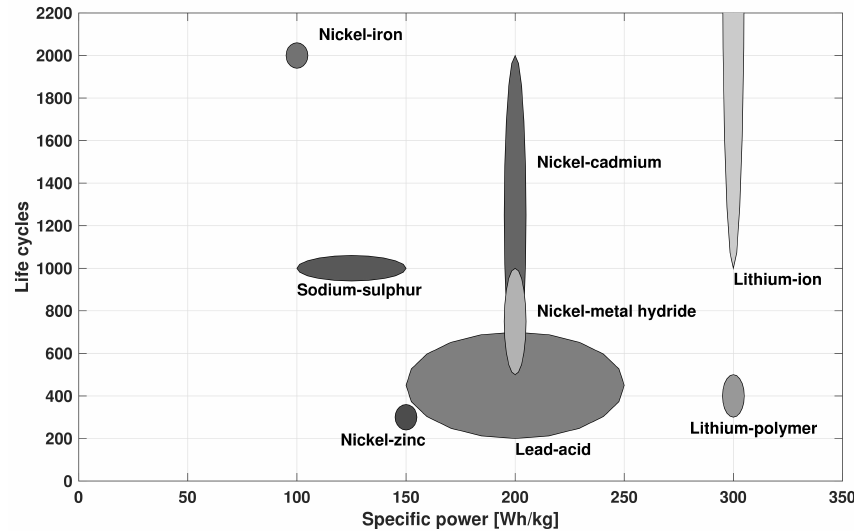
Figure 6. Battery specific power vs. number of cycles (data adapted from